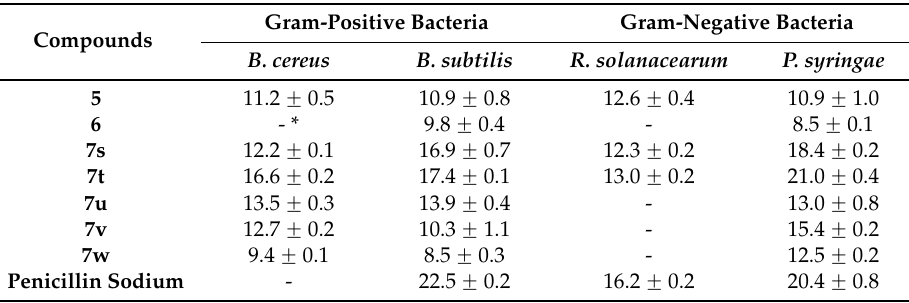
Table 2. Inhibition zones (mm) of some synthesized compounds (10 µ g). Compounds